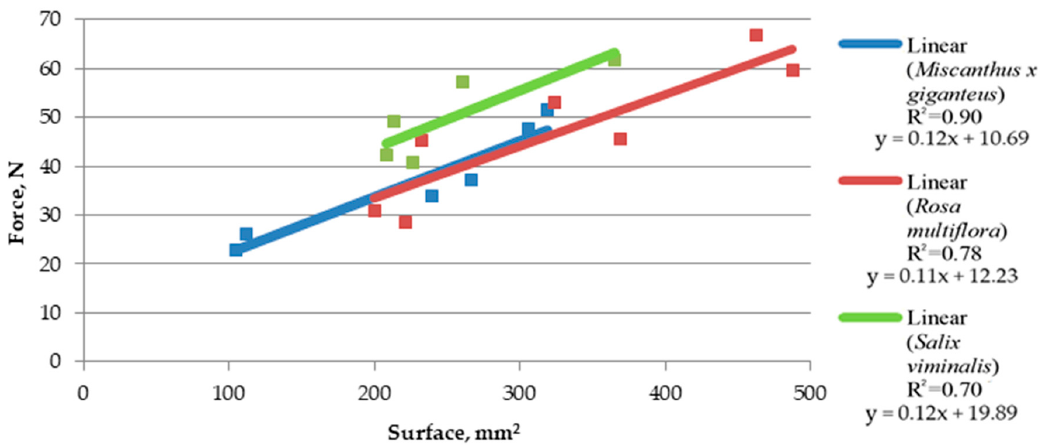
Figure 7. The average cutting force for the initial rotation speed n 1 = 4200 RPM.